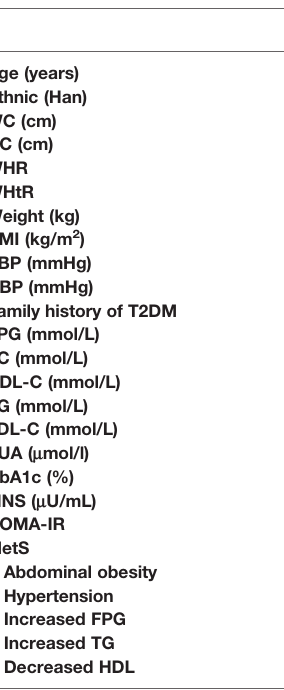
TABLE 1 | Characteristics of the study